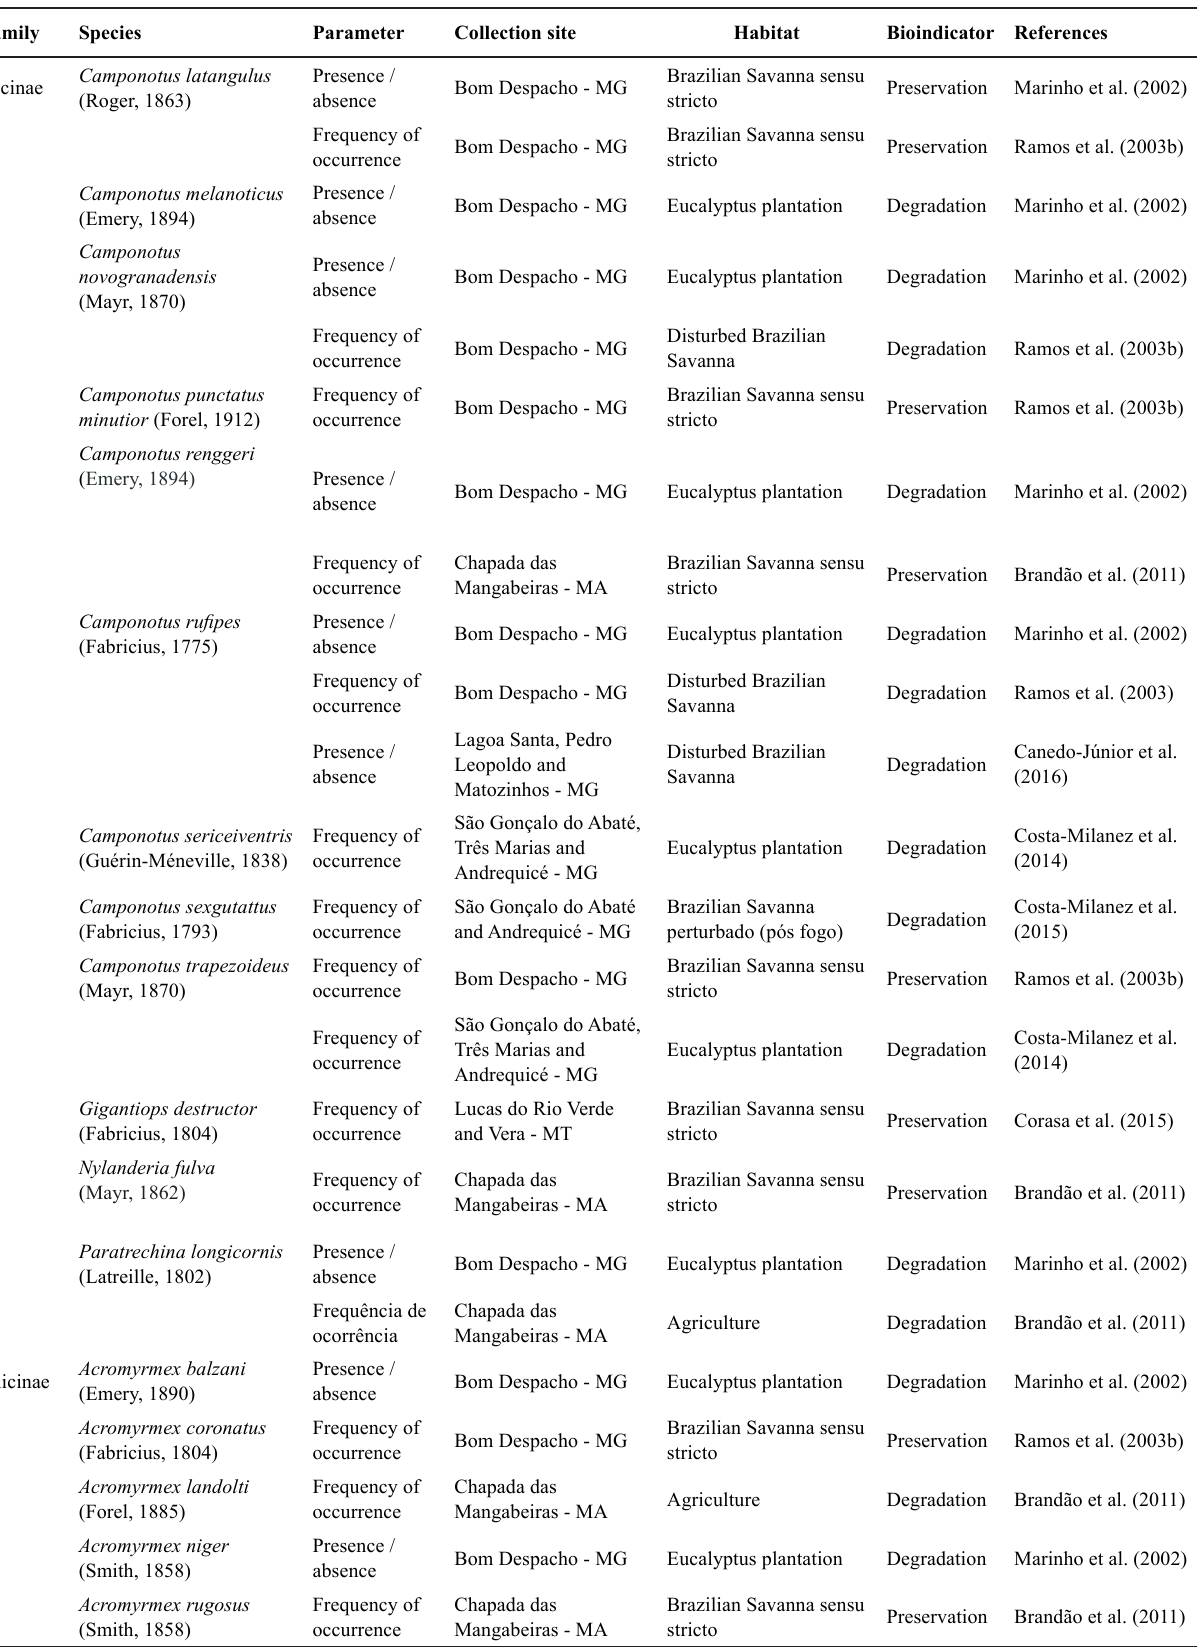
Table 3. Species of ants defined as bioindicators for preservation or degradation in the reference studys, indicating the parameter used to relate to the habitat type, and the reference of the papers analyzed.